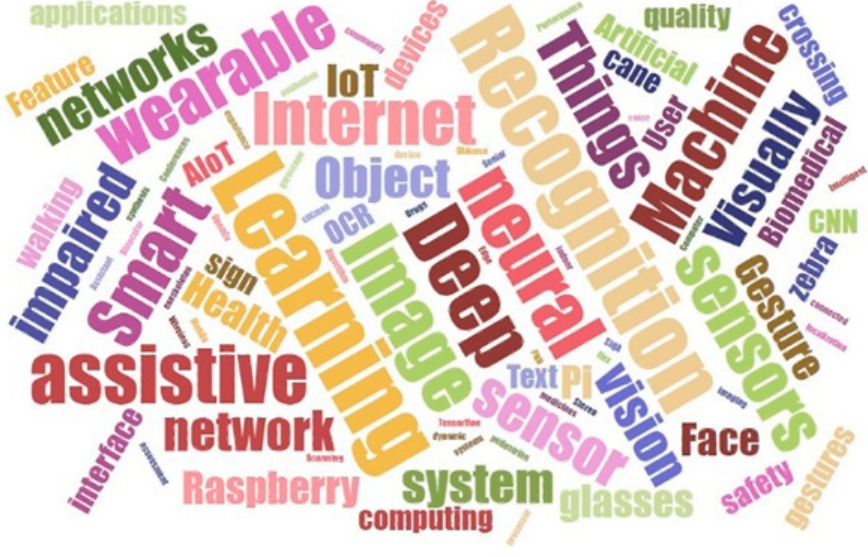
Figure 3. Word Figure 3. Word cloud.